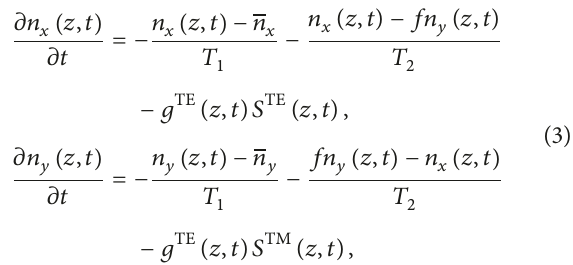
Figure 2: SOA acting as a PSW.